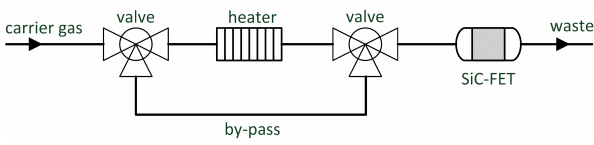
Figure 1. Schematic of the measurement